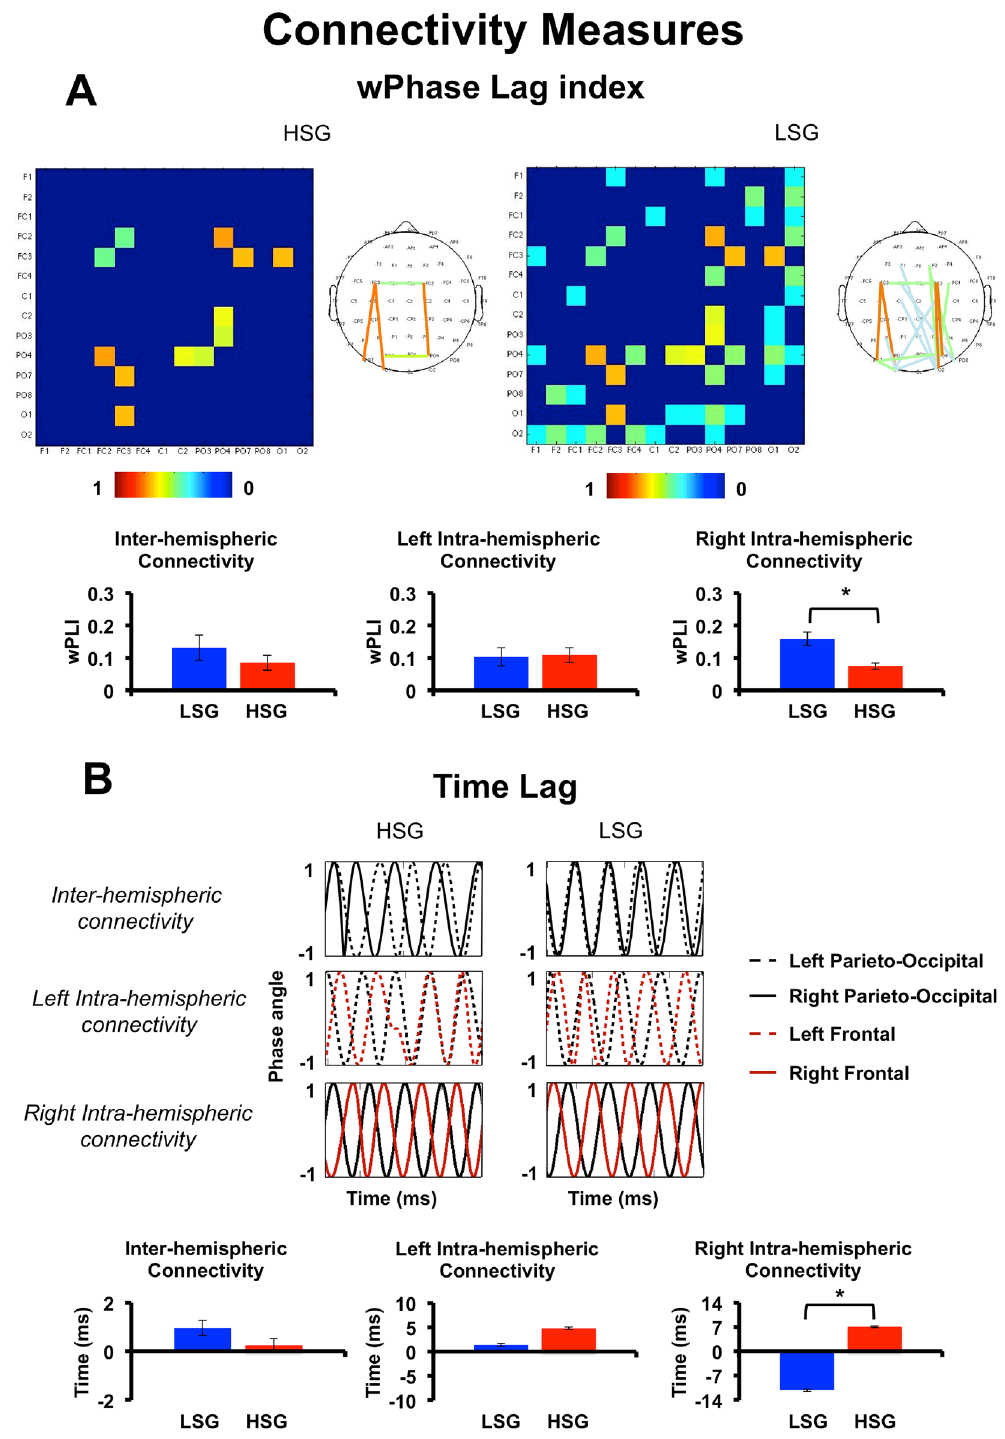
Figure 2. Connectivity Measures. ( A ) Correlation matrices of the weighted Phase Lag Index for the High Schizotypy (HSG) vs. Low Schizotypy (LSG) Groups in the selected subclusters of electrodes in the frontal and parieto-occipital ROIs. Topographies show grand mean wPLI connectomes for each electrode with wPLI > 0 (non-random connectivity). Bar graphs below show the corresponding mean wPLI in the selected ROIs for connectivity analyses (see methods). ( B ) Phase angles distributions over time, plotted as sinusoid oscillations, in the selected ROIs for connectivity analyses based on time lag. First row shows oscillations in left and right parieto-occipital ROIs (inter-hemispheric connectivity) for HSG and LSG. Second and third rows show oscillations in the frontal and occipito-parietal ROIs in the left and right hemisphere respectively (intra- hemipsheric connectivity). Bar graphs below show the corresponding mean Time lags for left and right inter-hemispheric and intra-hemispheric connectivities in both groups. Error bars represents Standard error of the mean. ms (milliseconds); Hz